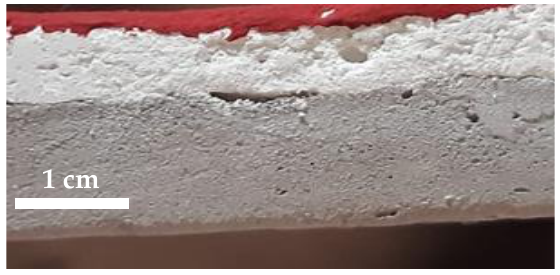
Figure 1. Stratigraphy of the specimens; from the bottom: concrete, plaster, painted layer. Three samples were used as reference, while the others were coated by brush with